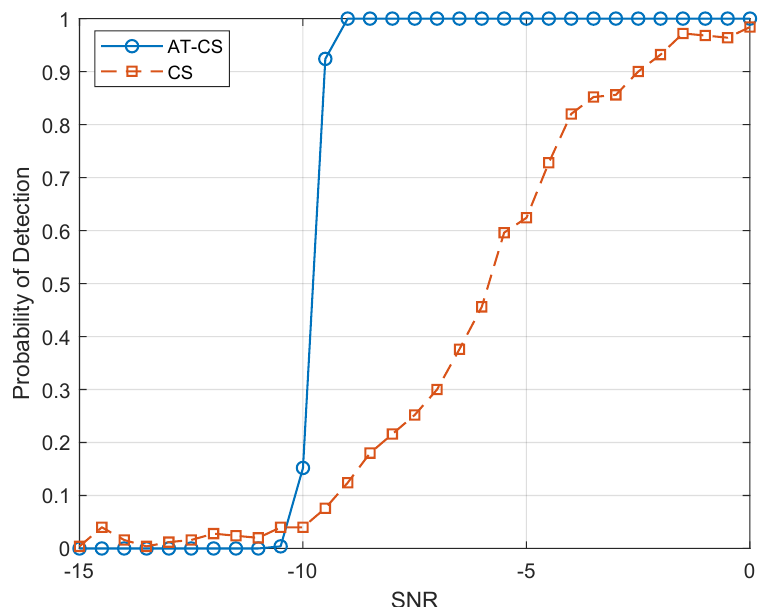
Figure 5. Detection probability of the sensing architecture using the time cyclostationarity and angle-time